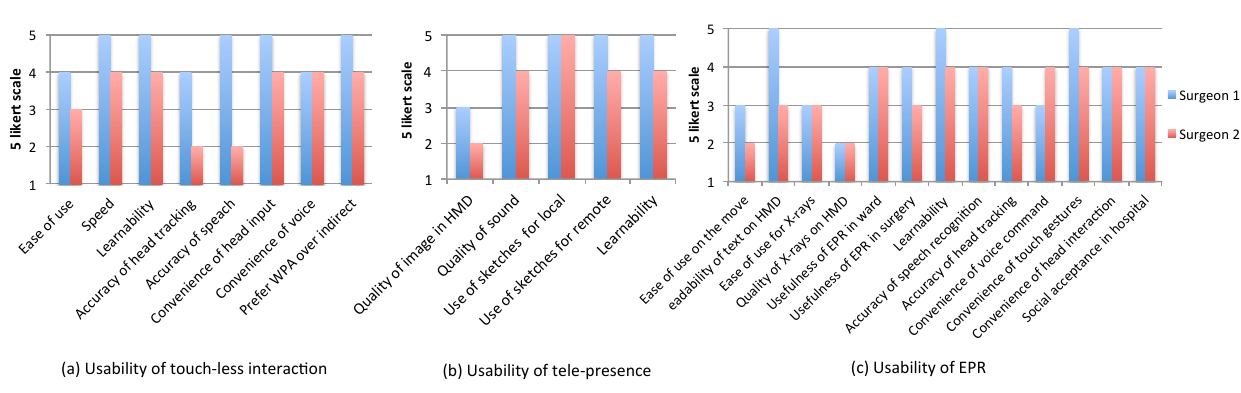
Figure 7. Perceived usability of a) the touch-less interaction module of the Wearable Personal Assistant (WPA), b) the tele-presence module of the WPA, and c) the Electronic Patient Record module of the